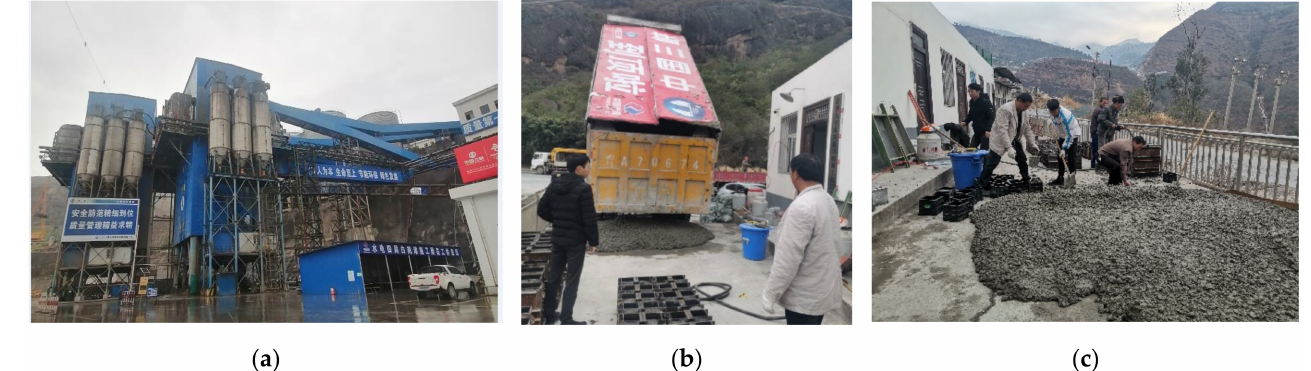
Figure 3. Production, transportation and pouring of concrete: ( a ) concrete mixing system at the construction site; ( b ) concrete transportation with thermal insulation dump truck; ( c ) pouring of